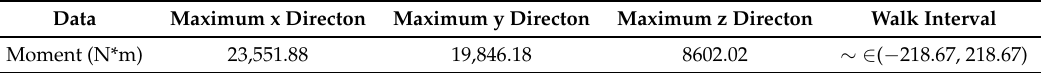
Table 1. Interesting force moments in the study: three directions correspond to maximum reached in a fall (with its value in module), and the last is a confidence interval in a walk.